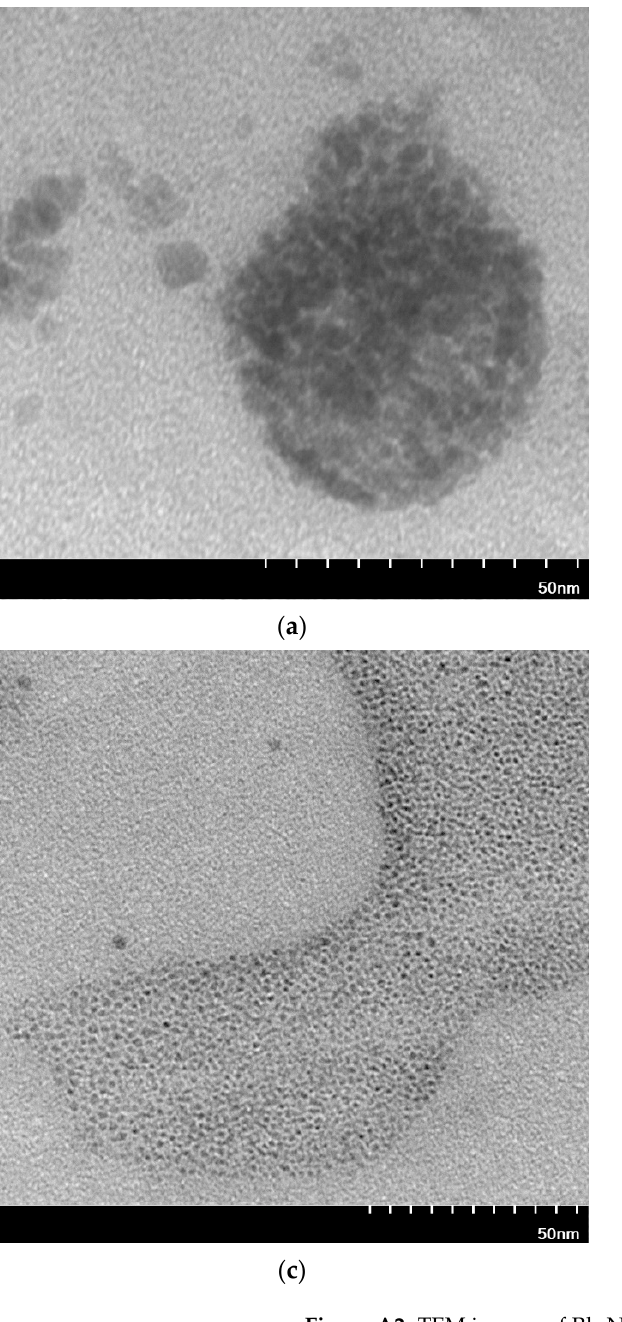
Figure A2. TEM images of Rh-NP ( a , b ) and Ru-NP ( c , d ) (molar ratio of PGM:PVP:reducer was 1:5:2) using AA for ( a , c ) and NaBH 4 for ( b , d ).